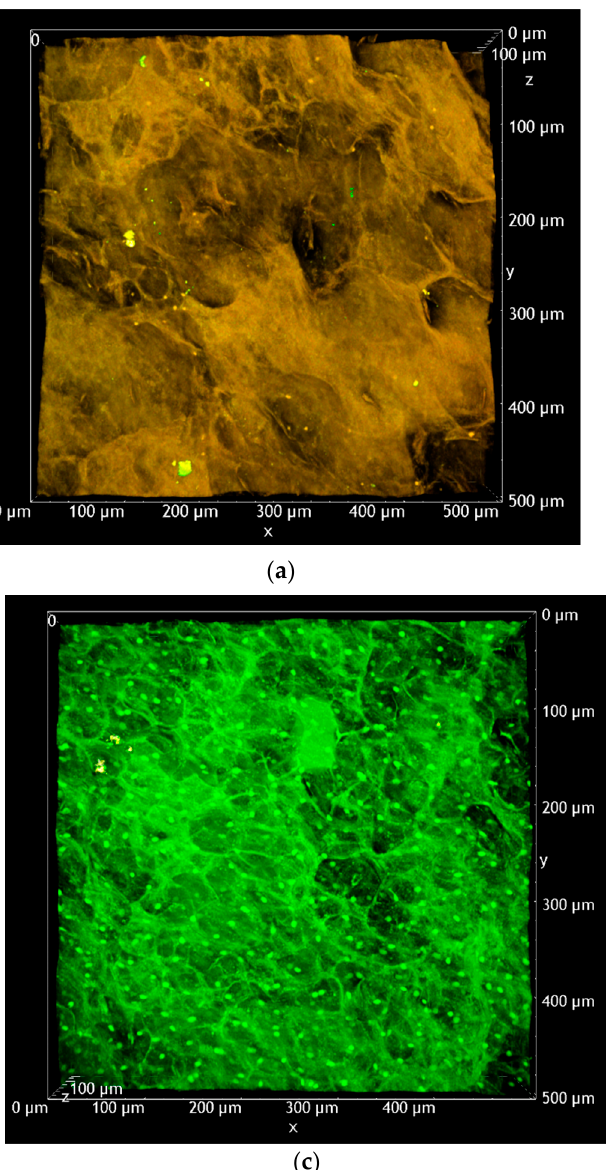
Figure 6. Volume renderings of the pre-treated with caprylic acid (C8) porcine esophageal epithelium, reconstructed from the Z-stack. Blank tissue: ( a ) XY view; ( b ) 3D overview. Test tissue treated with FD-70: ( c ) XY view; ( d ) 3D overview. All the images were acquired with an excitation wavelength of 1030 nm and equal detector gains in the green and red channels.